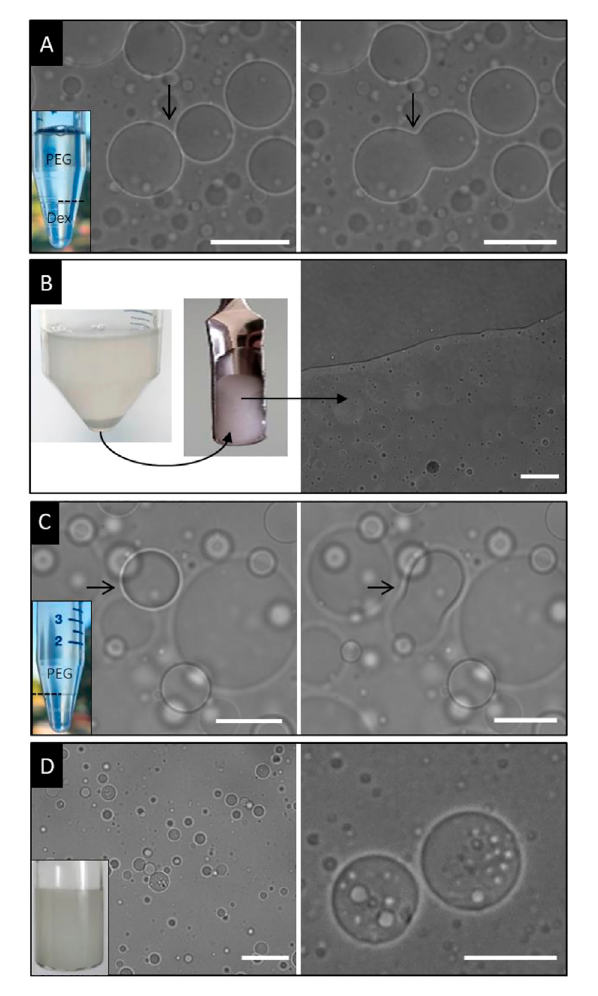
FIGURE 1 Addition of ethanol to ATPS (PEG/Dex). Panel (A) solvent free system showing macroscopic phase separation (left) of samples due tocoalescence ofdropletsasobservedbybright fi eldmicroscopy(the arrow points at a coalescence event). Scale bar is for 50 µm. Panel (B) sample tube photo (left) and spatula (middle) showing formation of gel Dex-rich pellet upon solvent shifting onto ATPS. The sampleisalsoobservedbybright fi eldmicroscopyshowingnodroplet (right). Scale bar is for 20 µm. Panel (C) sample tube photo (left) after macroscopic phase separation and solvent shifting onto ATPS- containing BSA using only half amount of ethanol (the arrow points at a coalescence event). Scale bar is for 20 µm. Panel (D) sample tube photo (left) after solvent shifting using the same volume of ethanol as that of ATPS (-containing BSA). The sample is constituted by small stable droplets that can entrap other droplets (the scale bar is for 20